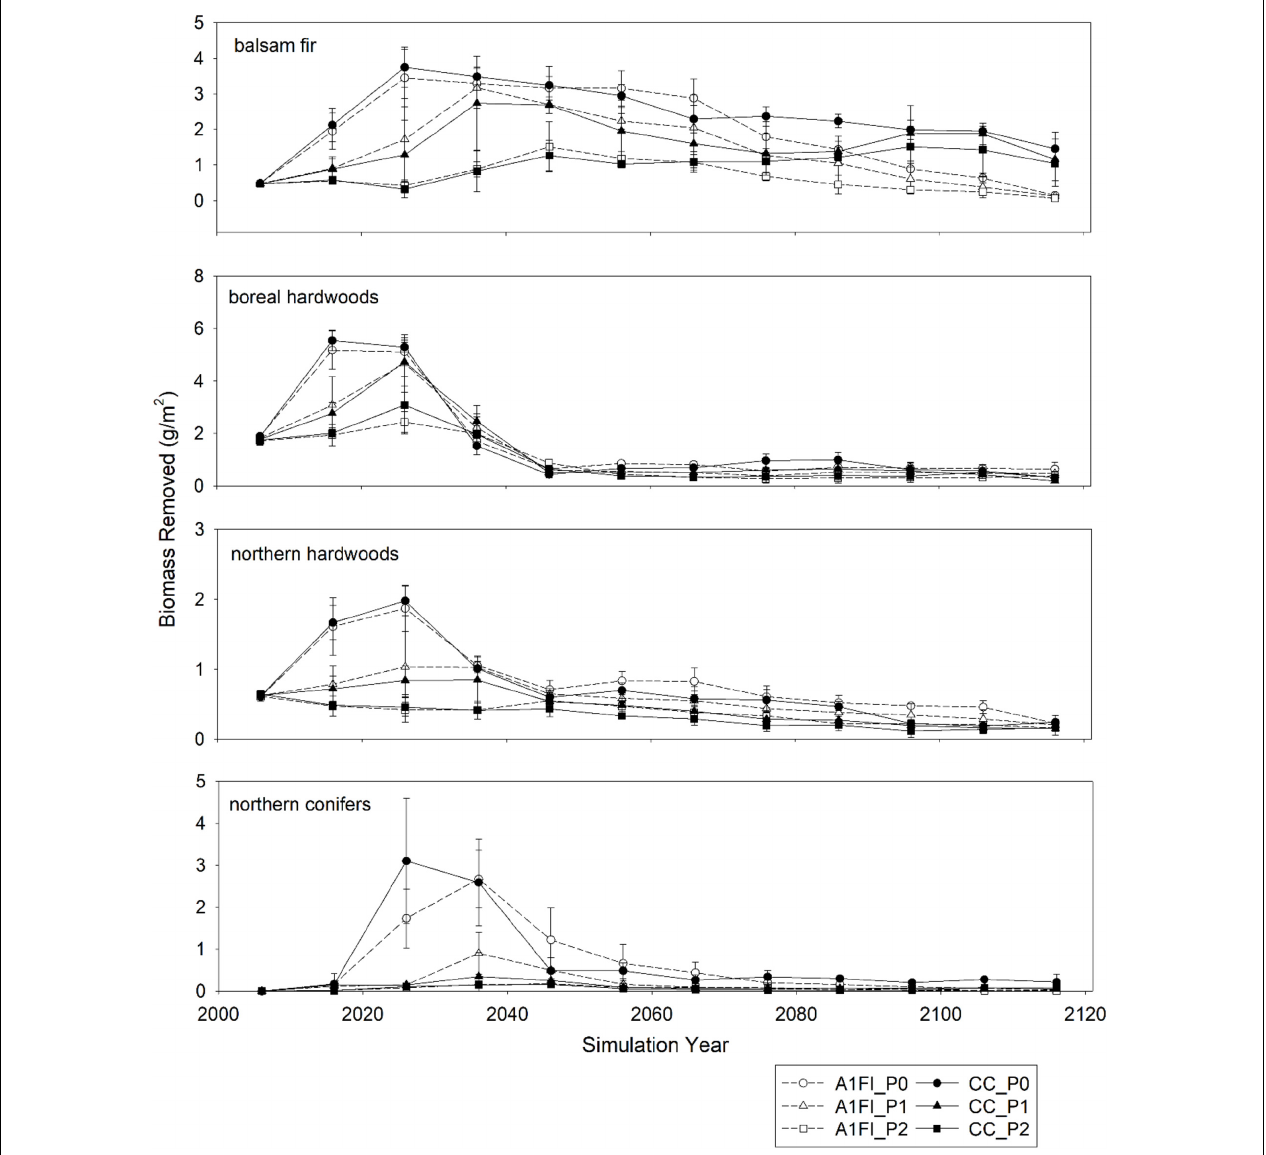
FIGURE 4 | Biomass removed due to browsing and browsing related cohort mortality for different predation and climate change scenarios. Data are area-weighted means ± 2 standard deviations for three replicate simulations for each